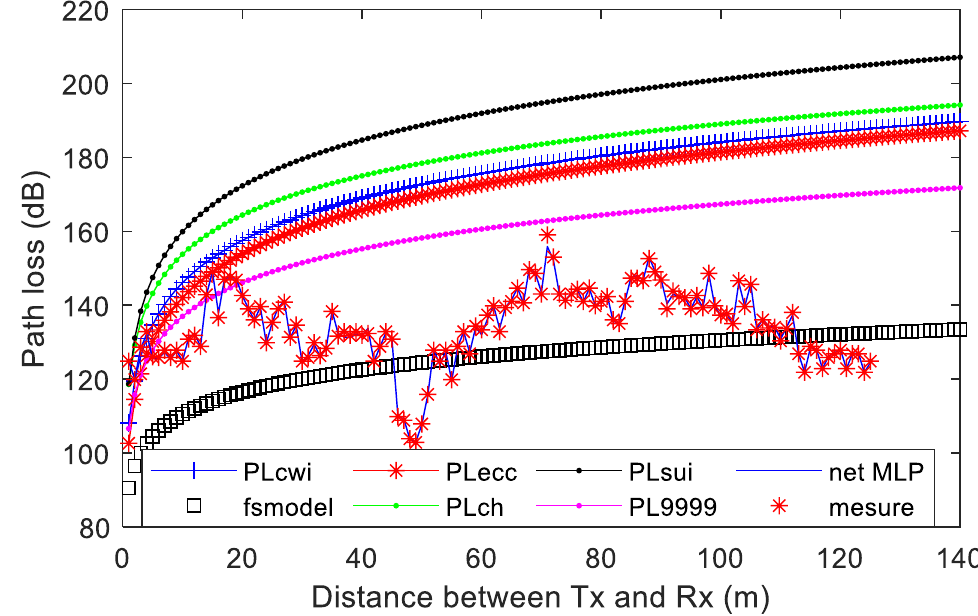
Figure 19. Comparison between empirical models and MLP (with three hidden layers) for Dataset 14.